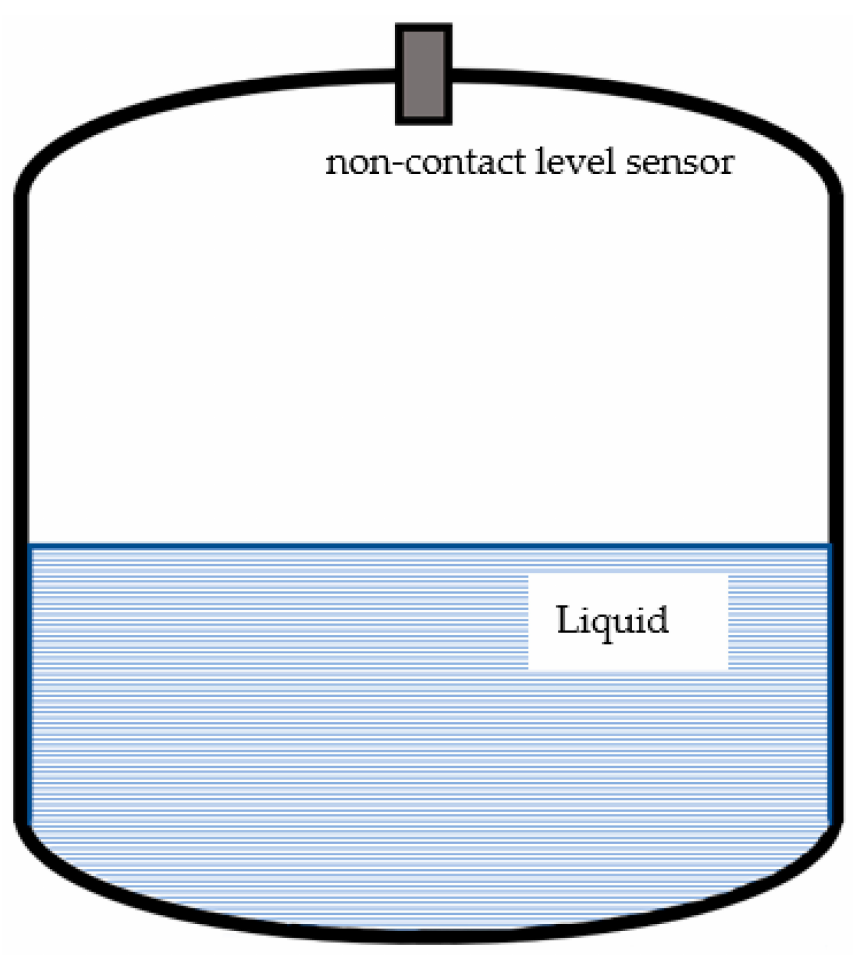
Figure 1. Tank with liquid and non-contact sensors on the top of the